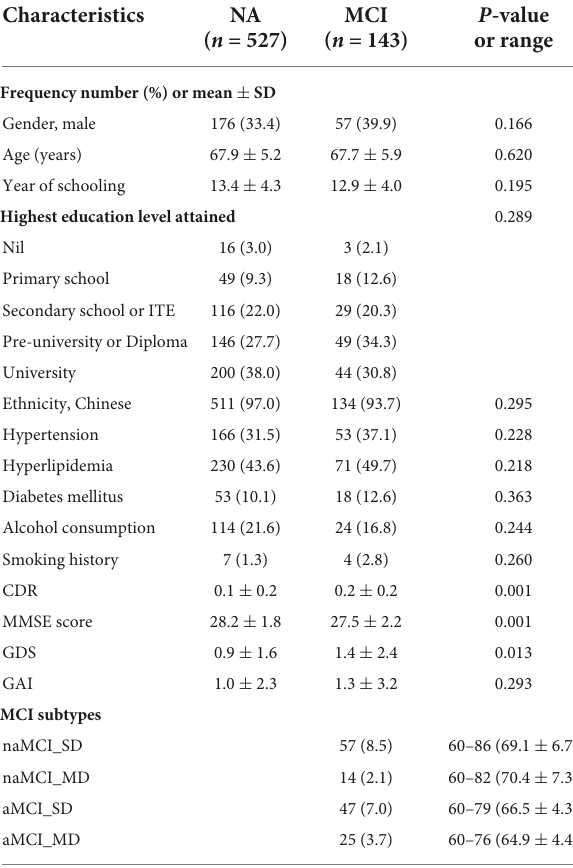
TABLE 1 Demographic characteristics, self-reported medical history, lifestyle, and cognition of 670